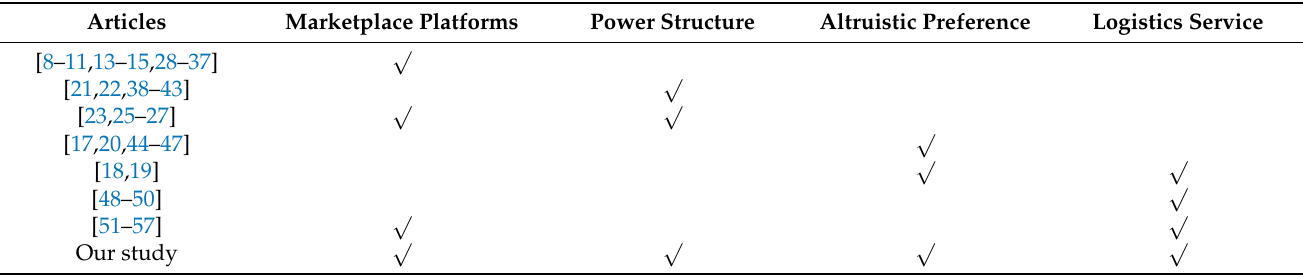
Table 1. The differences between previous studies and our study. Articles Marketplace Platforms Power